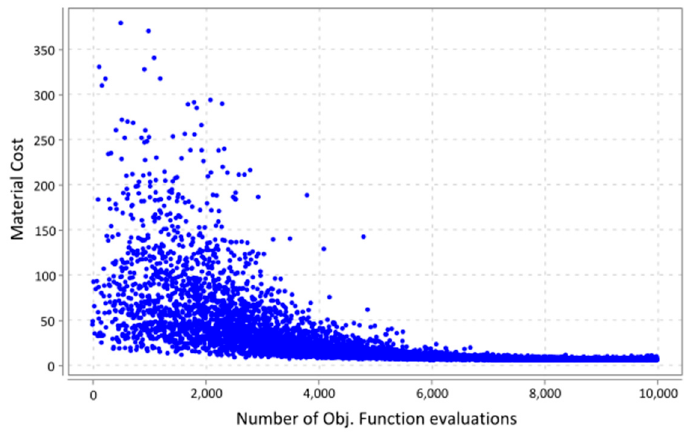
Figure 7. Example 1: Optimization algorithm progression. Buildings 2020 , 10 , x FOR PEER REVIEW